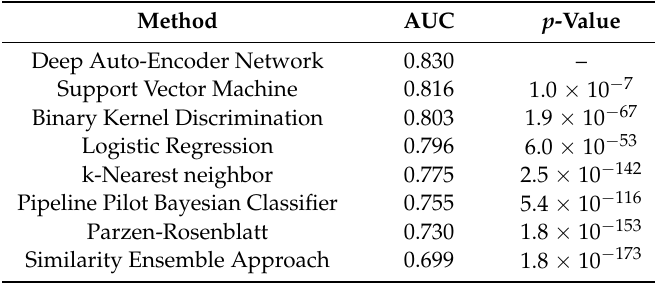
Table 3. Performance of target prediction methods analyzed by Unterthiner et al., in terms of mean AUC (Area Under the Receiver Operating Characteristic curve) across targets